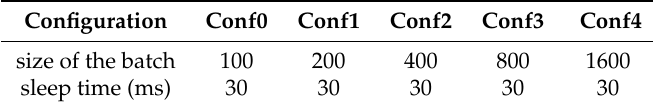
Table 1. Different configurations of Kernel Samepage Merging (KSM).